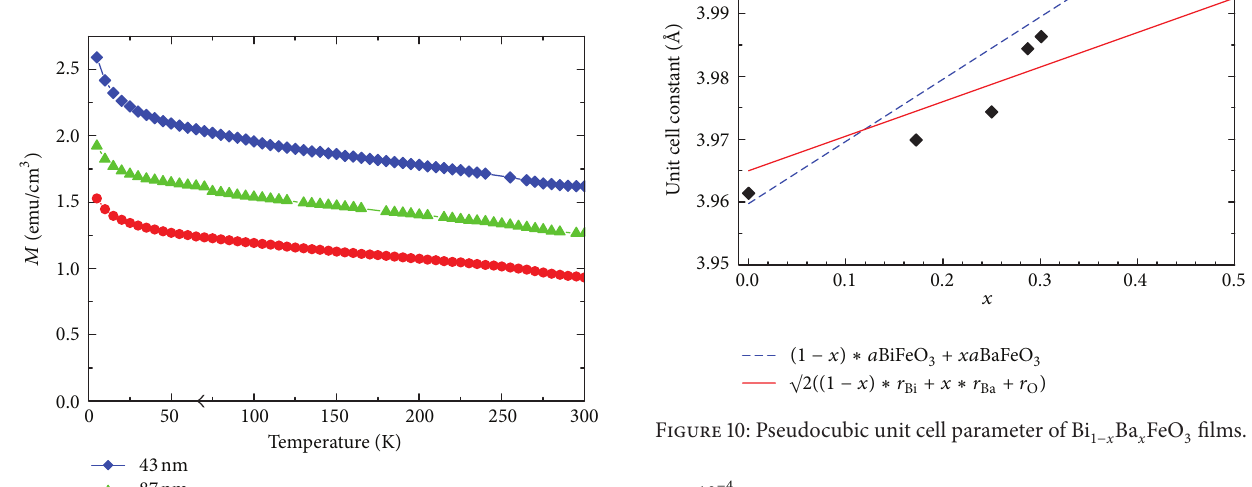
Figure 7: Hysteresis curves at 5K after field cooling under a field of 70 kOe. Only the low field range is shown.